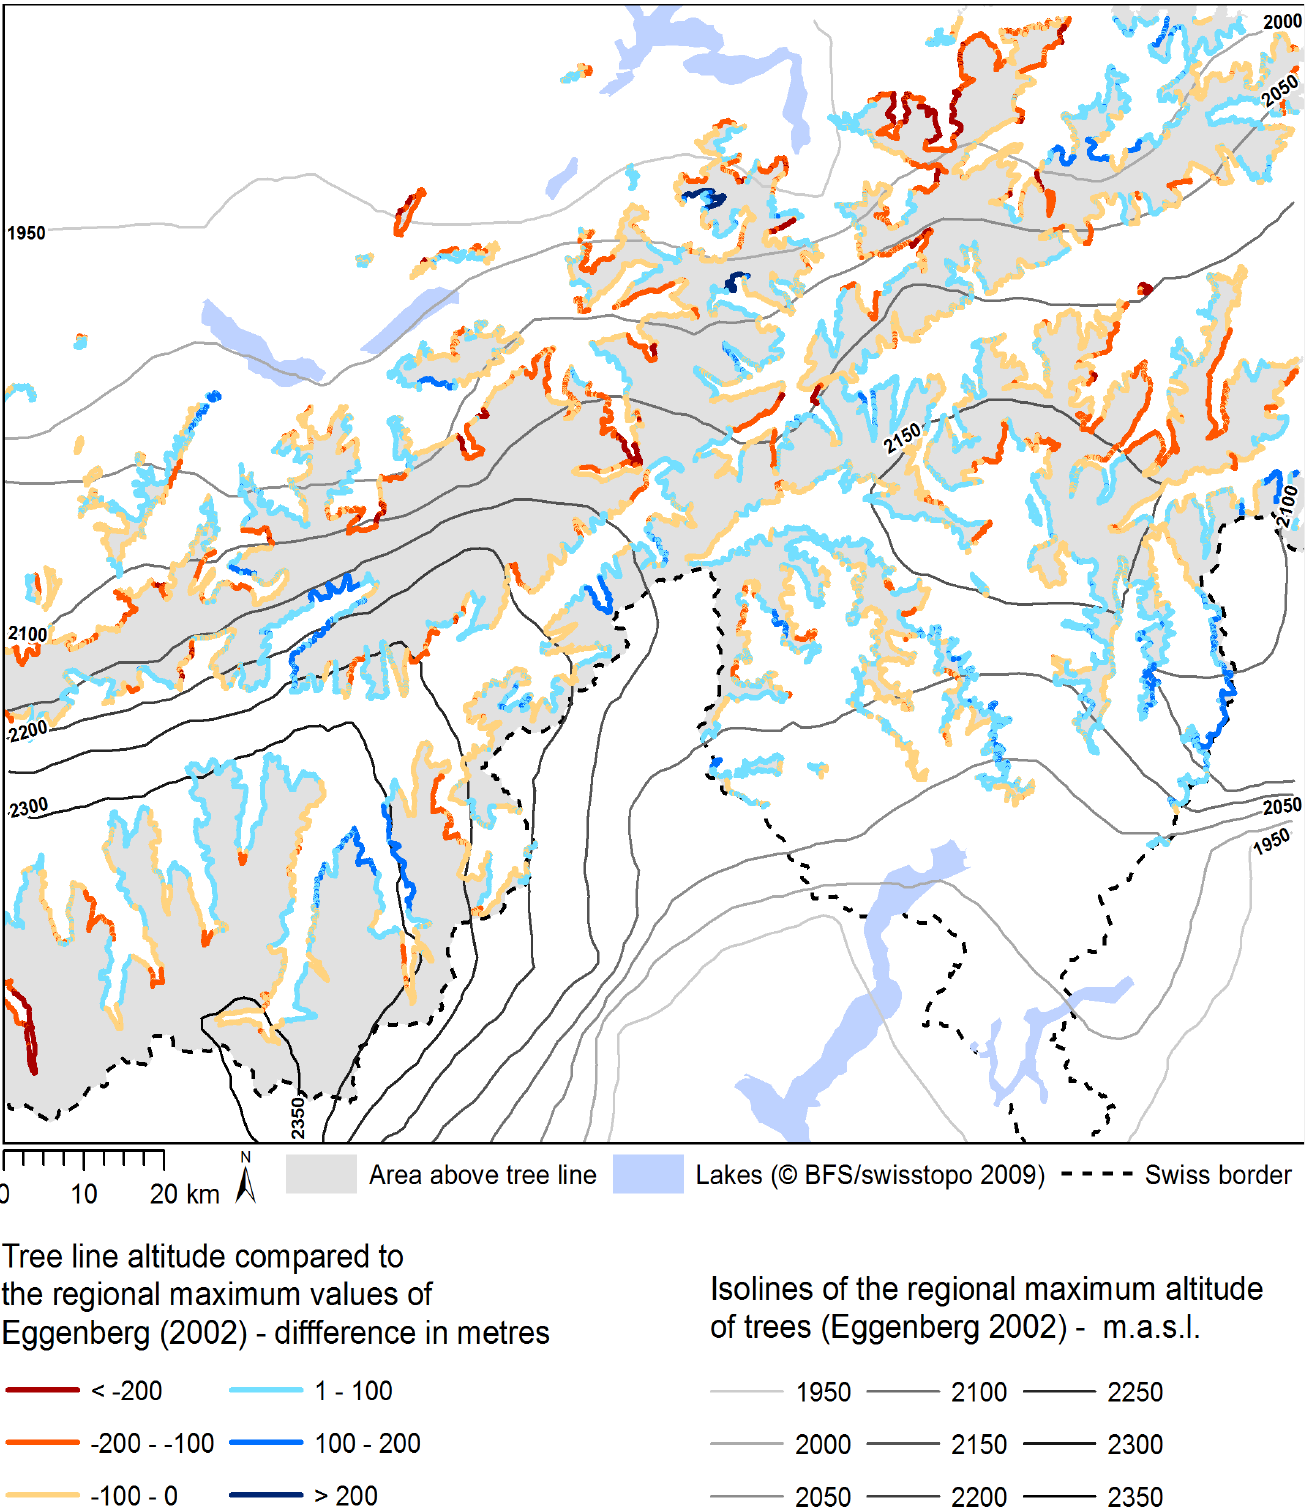
Figure 10. The red lines indicate that the modelled tree line is lower than the regional maximum altitude of trees derived from the isolines given by Eggenberg (2002). The blue lines indicate that the modelled tree line is higher than the regional